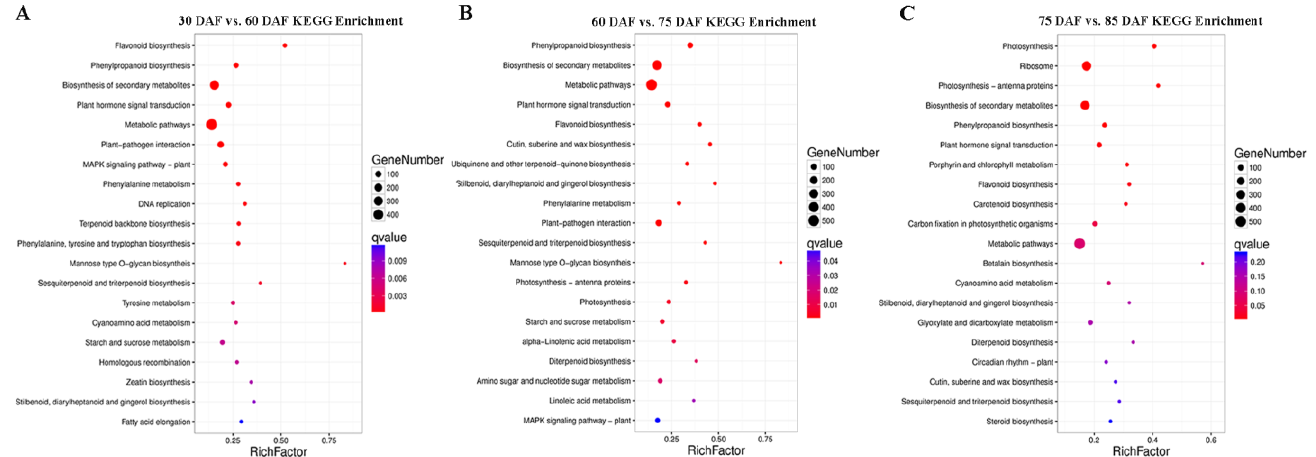
Figure 3. KEGG pathway enrichment analysis of DEGs during litchi fruit development. The 20 most significant catalogues with the lowest corrected q-values based on the DEGs by ( A ) 30 DAF vs. 60 DAF, ( B ) 60 DAF vs. 75 DAF, and ( C ) 75 DAF vs. 90 DAF comparison. The number of DEGs is indicated by the size of the circle, and the circle from red to blue represents the q-values.